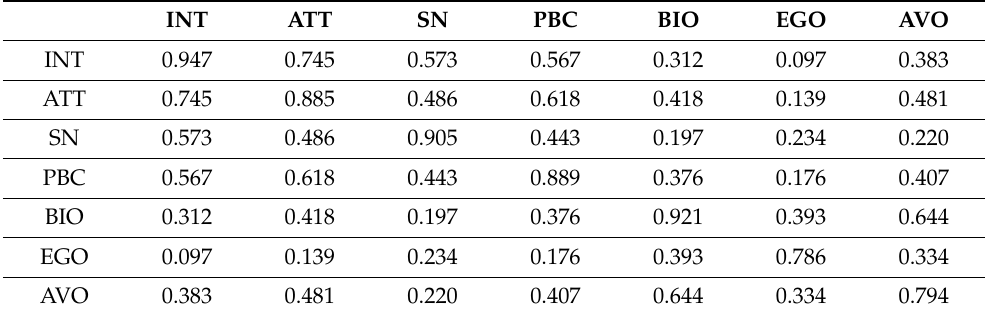
Table 4. Correlations among latent constructs with square roots of